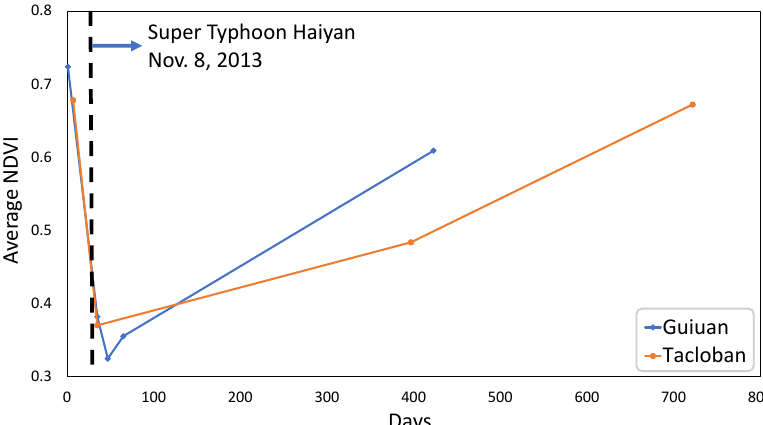
Figure 13. Change in mean NDVI value of the Guiuan and Tacloban areas.